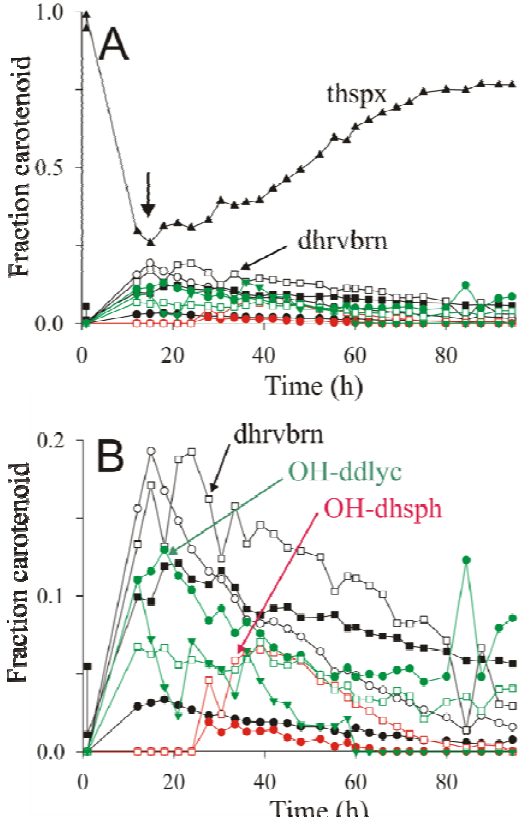
Figure 4. The fractional profiles of carotenoid dynamics calculated from the primary dynamic data shown in Figure